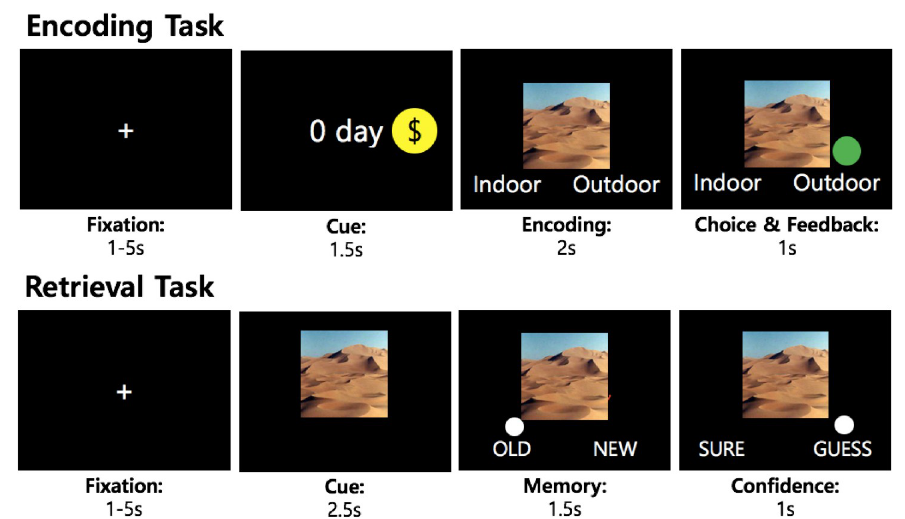
Fig 1. Experimental paradigm. Each trial in encoding and retrieval task was preceded with a jittered fixation. In the encoding task, correct response was followed by a green dot while incorrect response resulted in a red